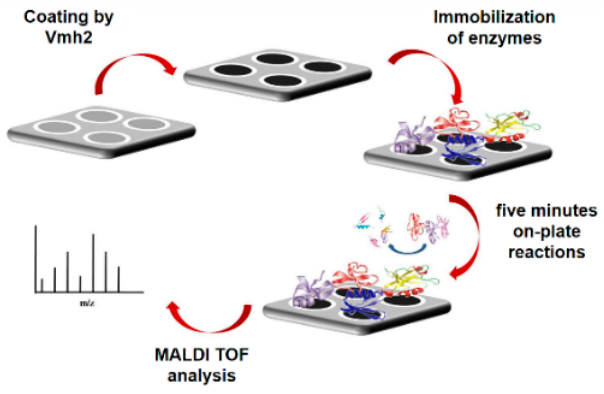
Figure 2. In situ reaction of trypsin immobilized on Vmh2 coated matrix ‐ assisted laser desorption/ionization time ‐ of ‐ flight mass spectrometry (MALDI ‐ TOF ‐ MS) sample plate.